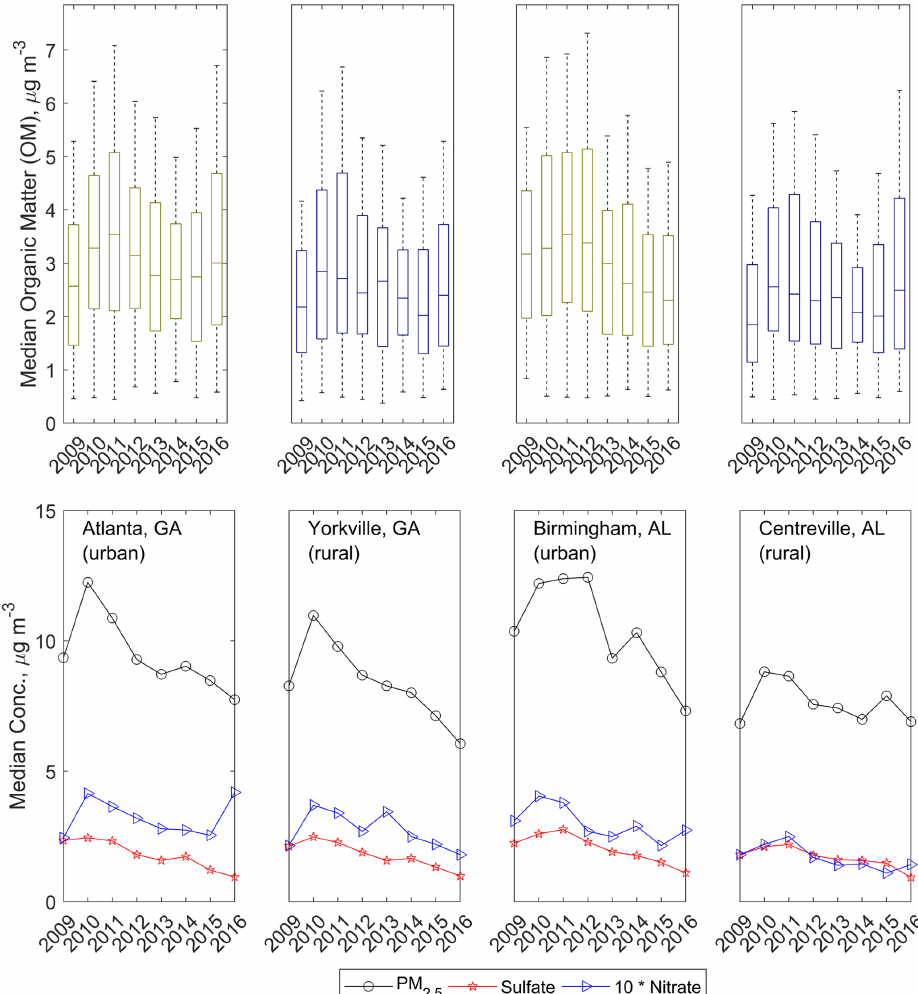
Figure 2. The top row shows annual median OM concentrations quantified via FT-IR spectrometry; colors indicate rural (dark blue) or urban (olive) site locale. The bottom row shows annual median total PM 2 . 5 concentration, particle SO 2 − measured in the SEARCH network. Column-wise subpanels correspond to individual sites, as indicated in the bottom